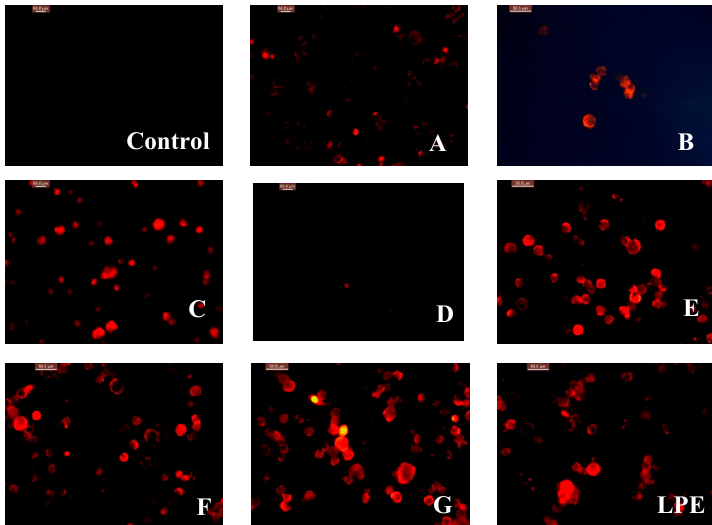
Figure 4. Fluorescence microscopy of A549 cell line treated with LPPs and purified LPE. (Control-untreated, A -protocatechuic acid, B -isoscopoletin, C -quercetin, D -ellagic acid, E -corilagin, F -proanthocyanidins C1, G -5-fluorouracil, LPE-Longan pericarp extract).